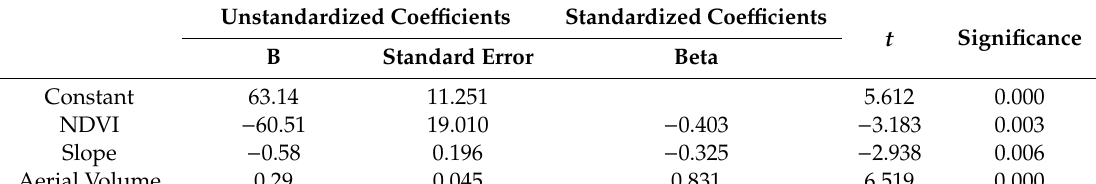
Table 1. Multiple regression coe ffi cients predicting olive tree yield.